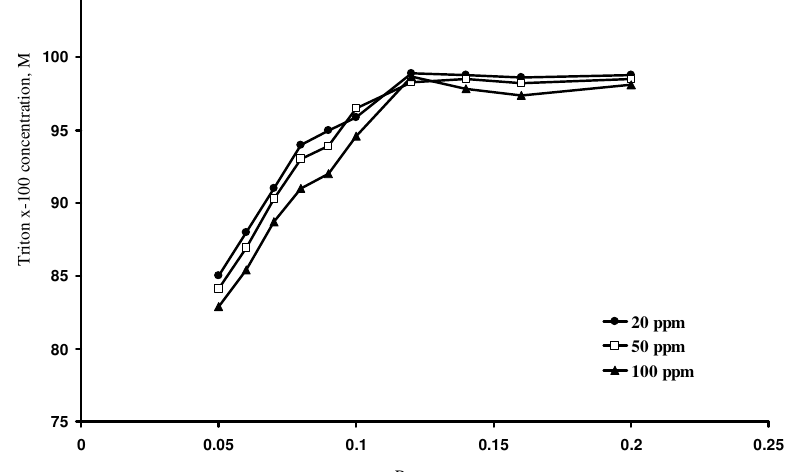
Figure 3. Effect of triton x-100 on removal of reactive black 5 ( Conditions: 50 mL of solution containing different concentration of dye (20, 50 and 100 ppm), 0.4 M of NaCl and pH 2, equilibration temp 65 o C and equilibration time 30 min, centrifuge time 10 min and centrifuge rates 3500 rpm